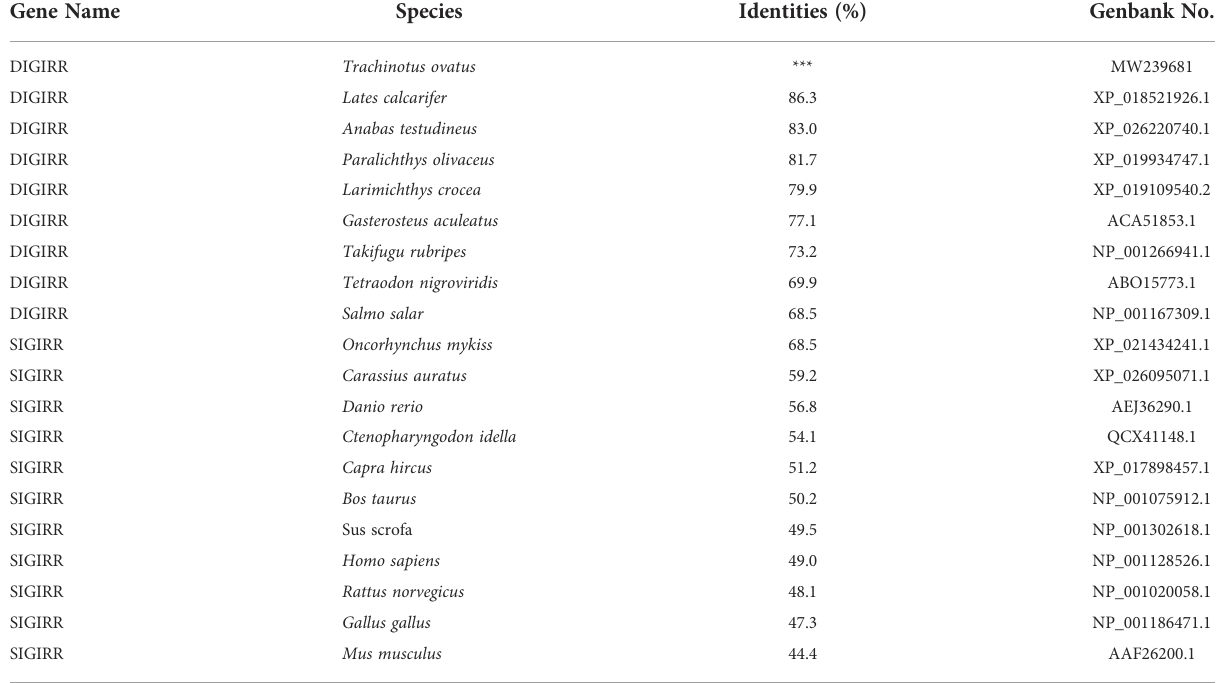
TABLE 2 Protein sequence identities between trDIGIRR and vertebrates ’